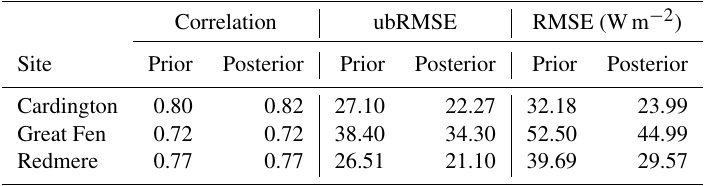
Table 5. Summary statistics for comparison of JULES-CHESS sensible heat estimates to flux tower observations over the experiment period. Over all sites, we find a 1% increase in correlation, 16% reduction in ubRMSE and 22% reduction in RMSE after performing the calibration using